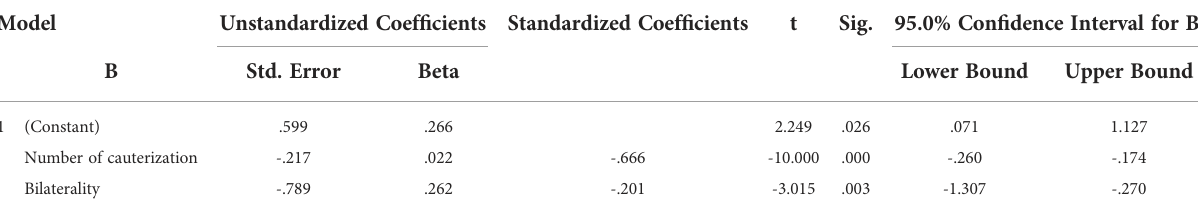
TABLE 3 The predictors of the amount reduction of serum AMH levels by the multiple linear regressions model. Coef fi cients a